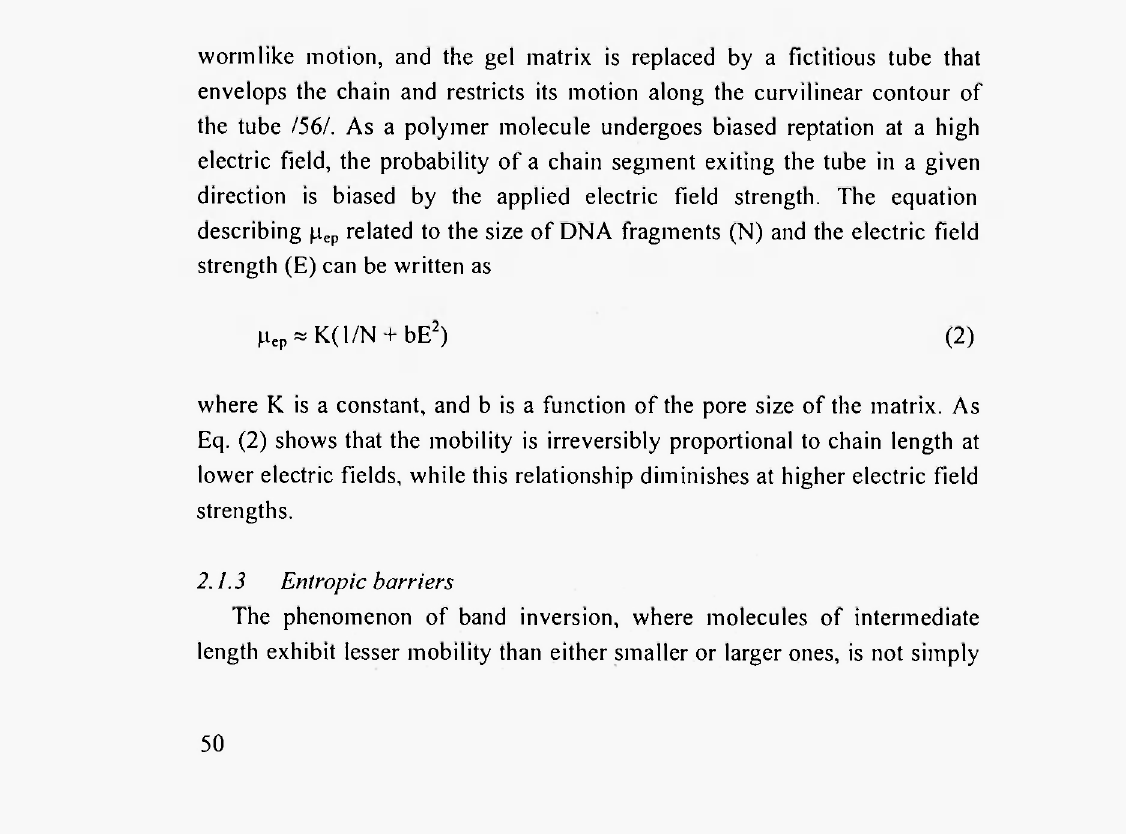
Fig. 2: Representation of the reptation model. The DNA chain migrate through gel matrix with wormlike